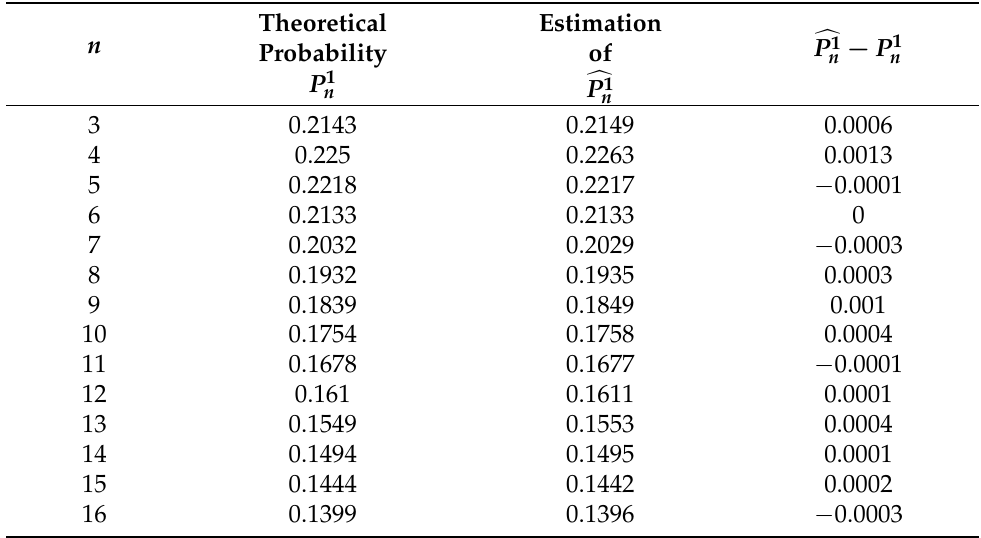
Table 7. For n = 3, . . . ,16: theoretical probability P 1 n and comparison with its estimate (cid:100) ( P 1 n ) by means of a swap in M = 1,000,000 of different initial